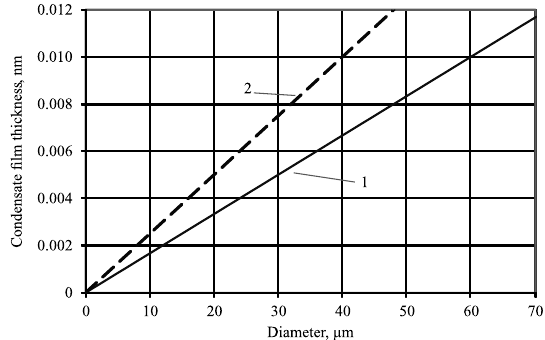
Figure 6. Dependence of condensate film thickness on the surfaces of cavity in the plant leaf ventilation system on the cavity diameter: curve 1 for a ball-shaped cavity; curve 2 – for a cylindrically-shaped channel when temperature changes by 1